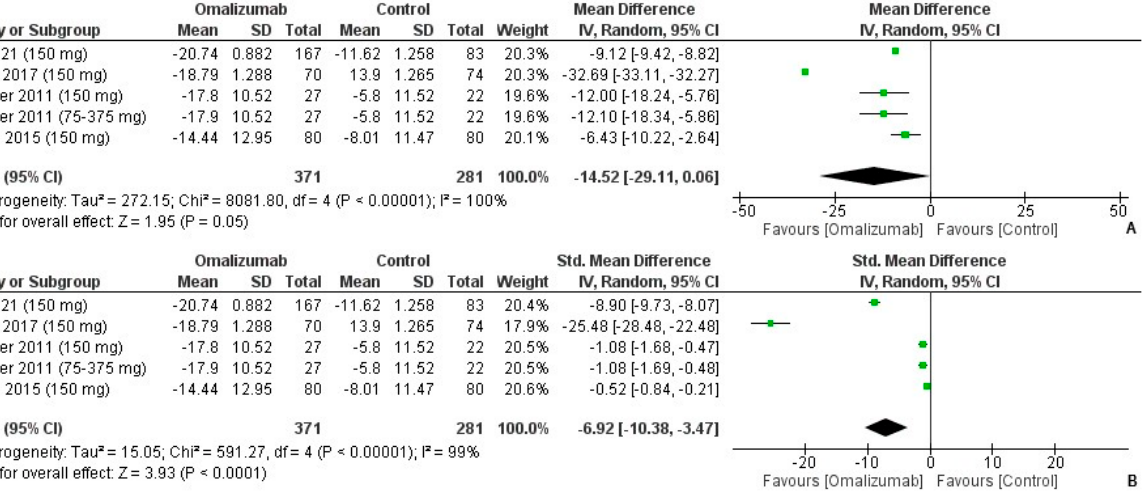
Figure 9. UAS7 outcomes with 150 mg dosage of omalizumab [17 − 19,25,26]. ( A ): Mean difference: − 14.52 [95% CI: − 29.11, 0.06]; Heterogeneity: Tau² = 272.15; Chi² = 8081.80, df = 4 ( p < 0.00001); I² = 100%; Test for overall effect: Z = 1.95 ( p = 0.05). ( B ): Standardized mean difference: − 6.92 [95% CI: − 10.38, − 3.47]; Heterogeneity: Tau² = 15.05; Chi² = 591.27, df = 4 ( p < 0.00001); I² = 99%; Test for overall effect: Z = 3.93 ( p < 0.0001).